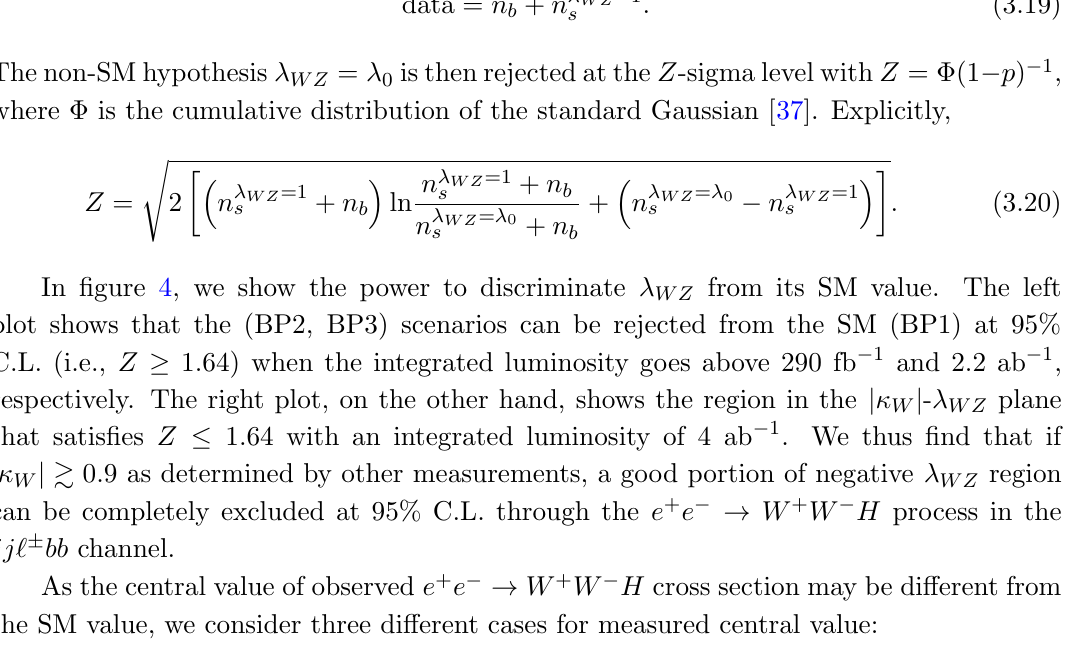
0 : 8 ; +0 : 3). Left: discriminating the (BP2, BP3) scenarios from the (cid:0) (cid:20) W - (cid:21) WZ plane that satis(cid:12)es Z j j